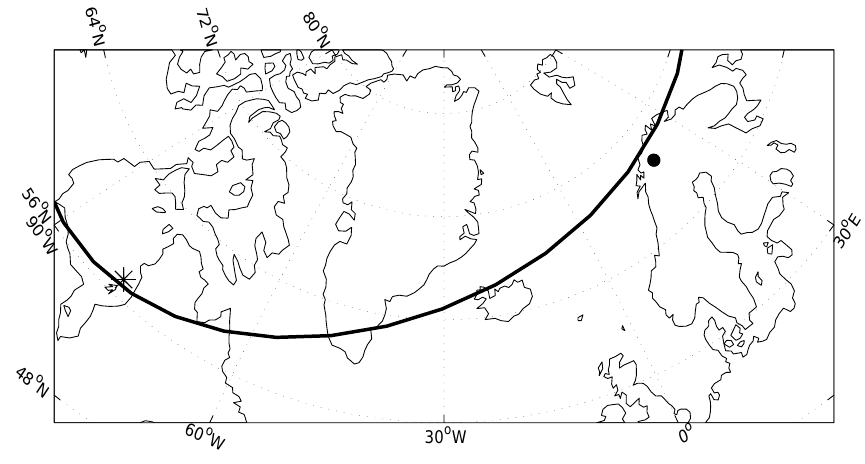
Fig. 1. Map displaying the position of the GOES 8 footprint (indicated by *) and the field of view of the IRIS wide beam riometer (at 90km altitude). The footprint of L = 6 . 5 is depicted as a thick black line demonstrating that the two instruments are on similar L shells. These are average values having been calculated for each year (from 1995 to 2001) using the International Geomag- netic Reference Field (IGRF)